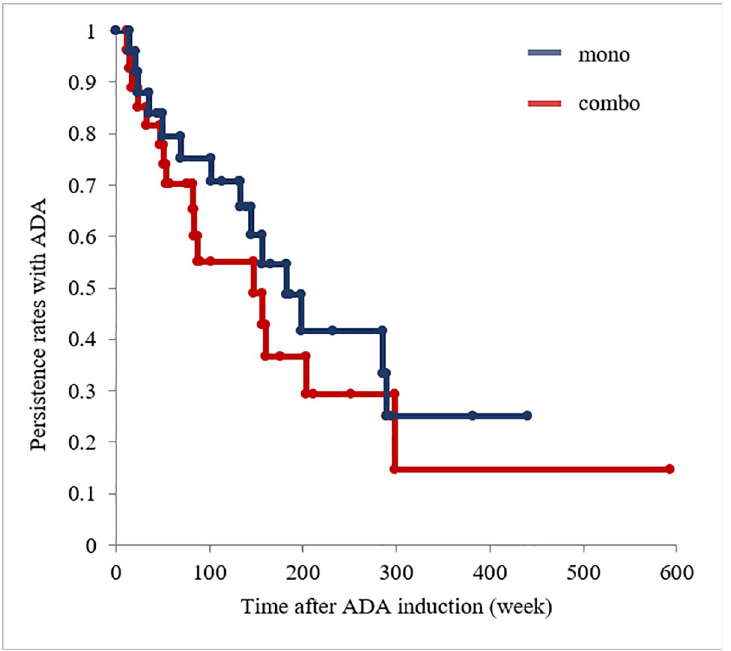
Fig 4. Kaplan–Meier curves of time to ADA discontinuation in patients in the ADA monotherapy group vs. those in the ADA plus immunomodulator combination therapy group ( P = 0.40 by log-rank test). Mono, monotherapy; combo, combination therapy; ADA,